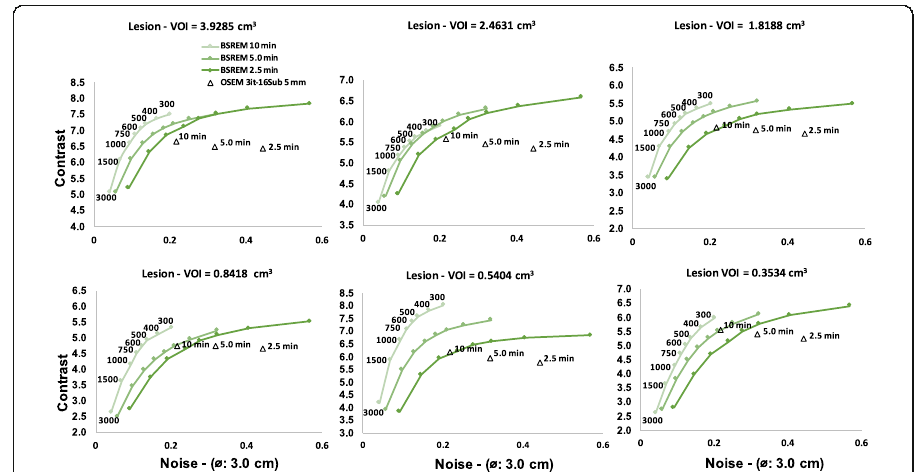
Fig. 6 Contrast (SUV ratios) of BSREM ( β = 300 – 3000, including TOF and PSF) and TOF-OSEM (3 iterations,